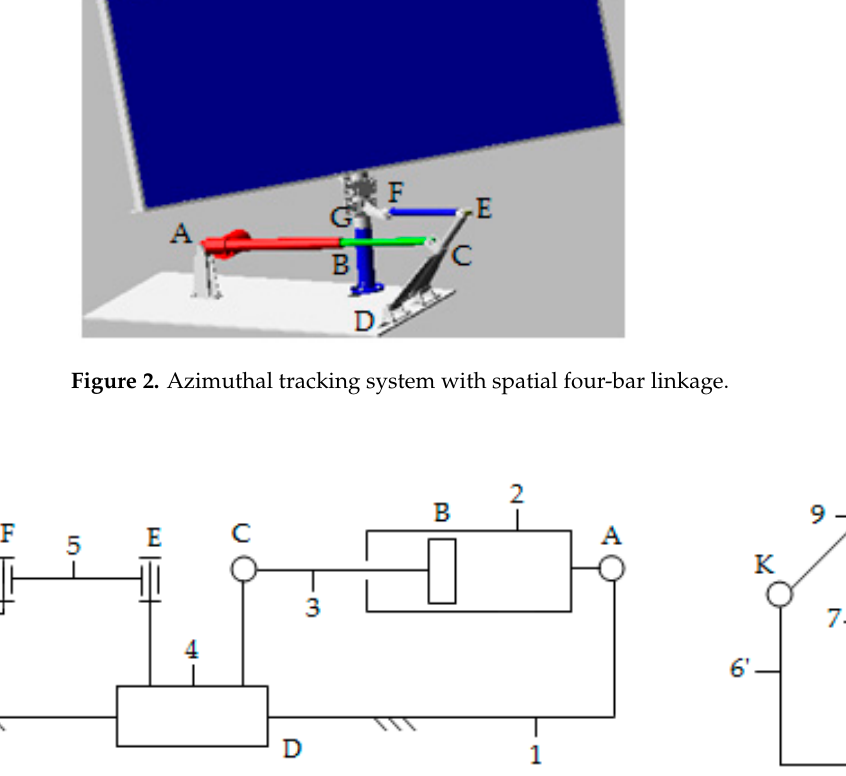
Figure 2. Azimuthal tracking system with spatial four-bar linkage.